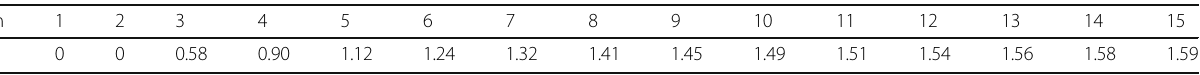
Table 6 Average random consistency indicator. (Source: